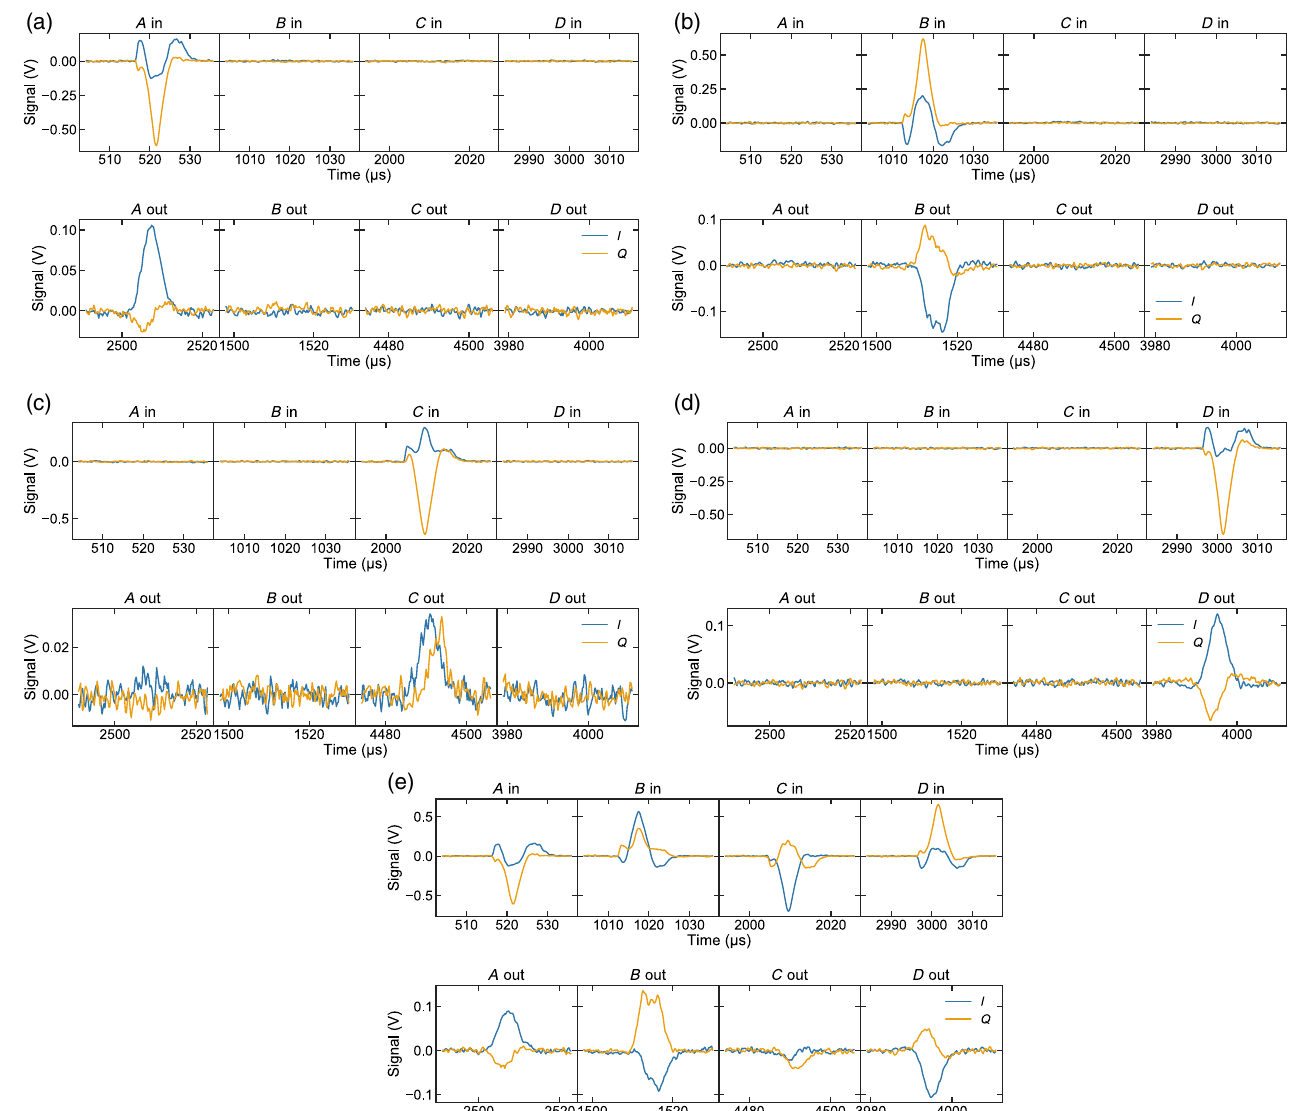
FIG. 15. The same memory sequence as shown in Fig. 5 was performed here at higher input power ( ∼ 15 000 photons per excitation pulse); the raw transient trace of the sequence is shown in (e). In (a) – (d) the same experiment was repeated with only one of each of the four input excitation pulses, A , B , C , and D , turned on. This allows us to unambiguously determine which echo originates from which excitation pulse. We see that a single echo appears in the expected read slot in each case. We also see that no other echoes appear when only one excitation is turned on. In this power regime, as well as amplifying (nonlinearly), the JPA also imparts poorly characterized phase shifts seen particularly when comparing (c) –